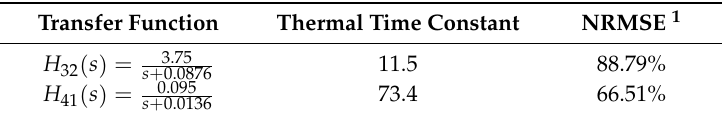
Table 1. Identification Results.